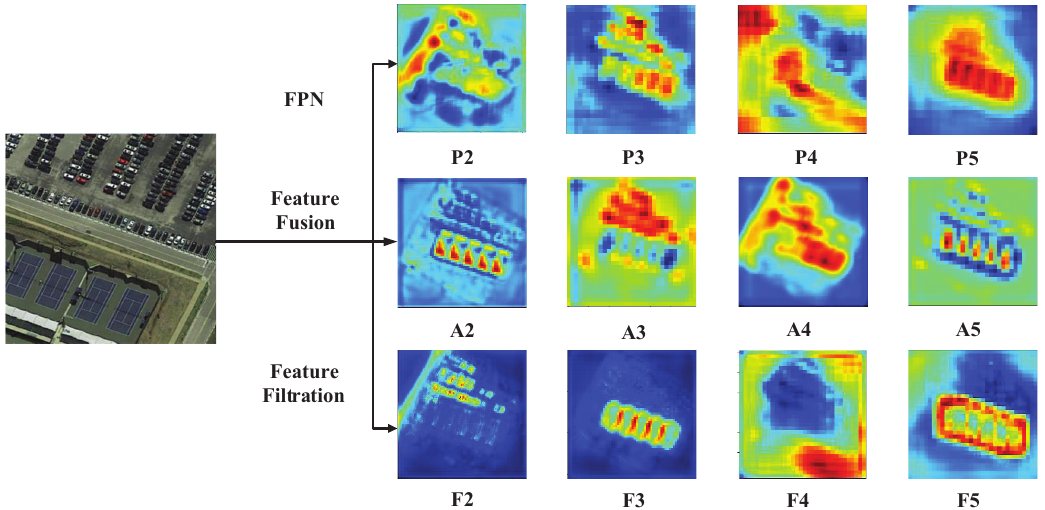
Figure 3. Visualization of feature maps produced by FPN ( { P 2 , P 3 , P 4 , P 5 } ), feature fusion module ( { A 2 , A 3 , A 4 , A 5 } ), and feature filtration module ( { F 2 , F 3 , F 4 , F 5 } ). For an image containing two categories, i.e., tennis court and small vehicle, feature fusion module can yield more precise context information than FPN. The feature filtration module is able to make the network focus more on the targeted objects, facilitating more accurate